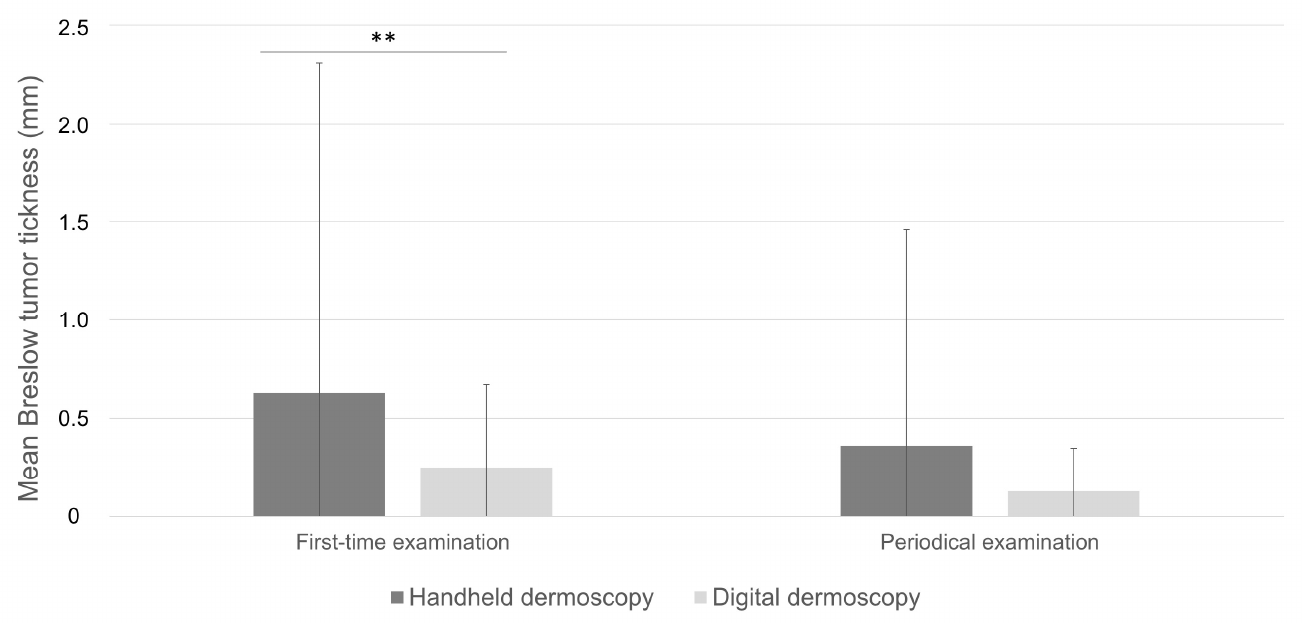
Figure 2. Mean Breslow tumor thickness in melanomas diagnosed on first-time examination com- pared to periodical dermoscopy. **: p < 0.01.